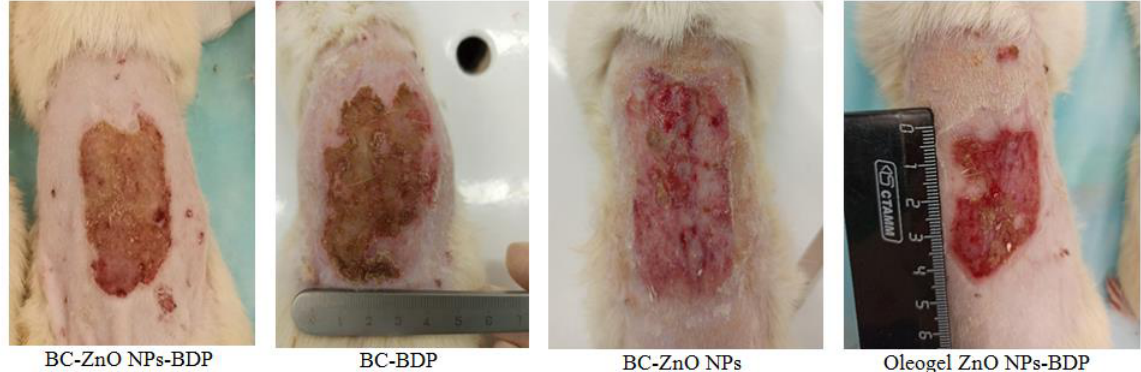
Figure 11. The burn wound state on day 21 after treatment.